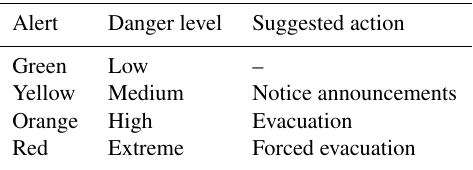
Table 8. Alerts and the corresponding danger levels, as well as sug- gested